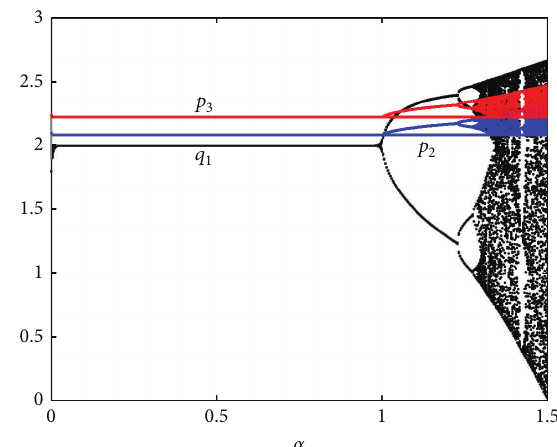
Figure 9: The trend of system with 𝑘 increasing for 𝛼 = 1.35 , 𝛽 = 0.15 , and 𝛾 = 0.2 .